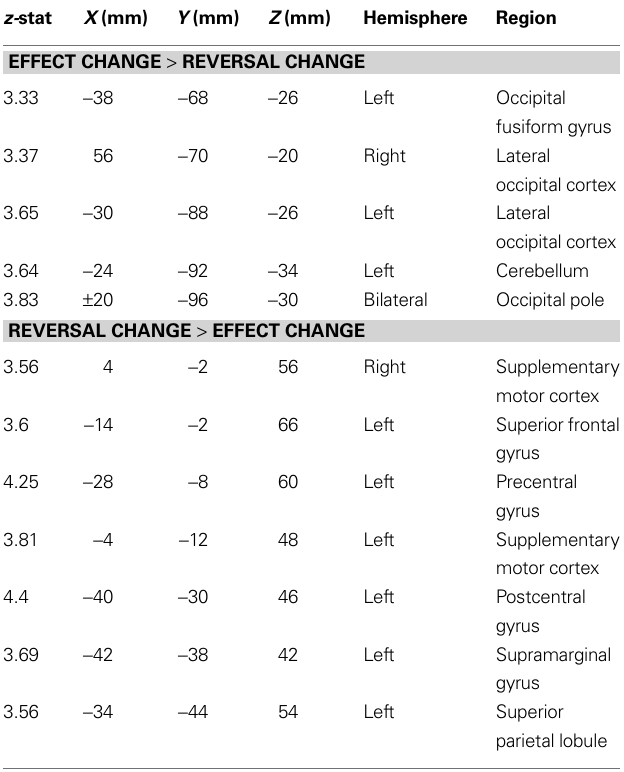
Coordinates indicate the peak voxel (i.e., maximal z score) within each anatomical